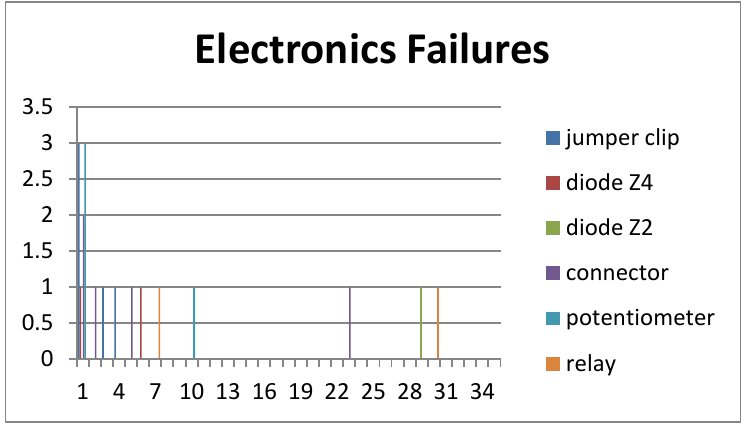
Figure 4. Flow Measurement Instrument Failure Mode Plot of All Electronics Components.